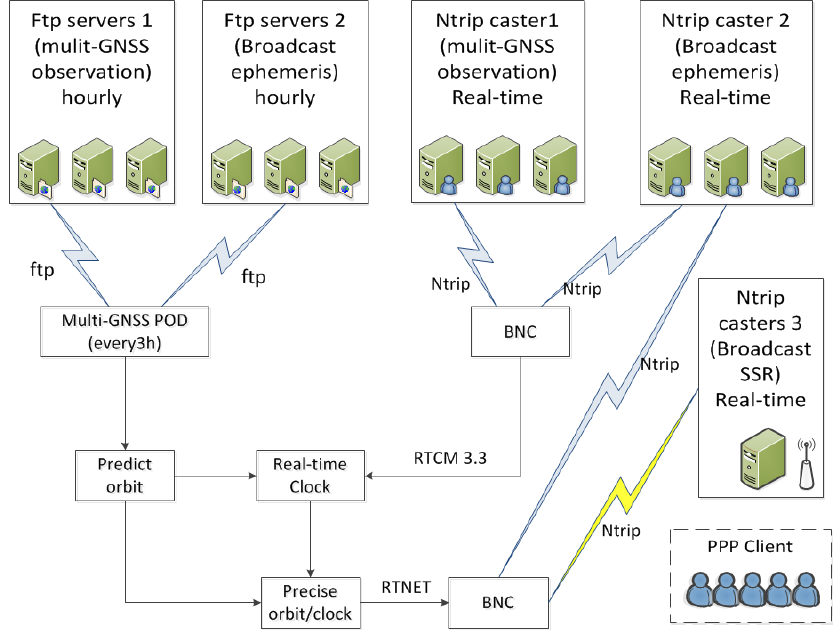
Figure 4. Flow chart of the real-time precise positioning service system based on the Position and Navigation Data Analyst (PANDA) software package.